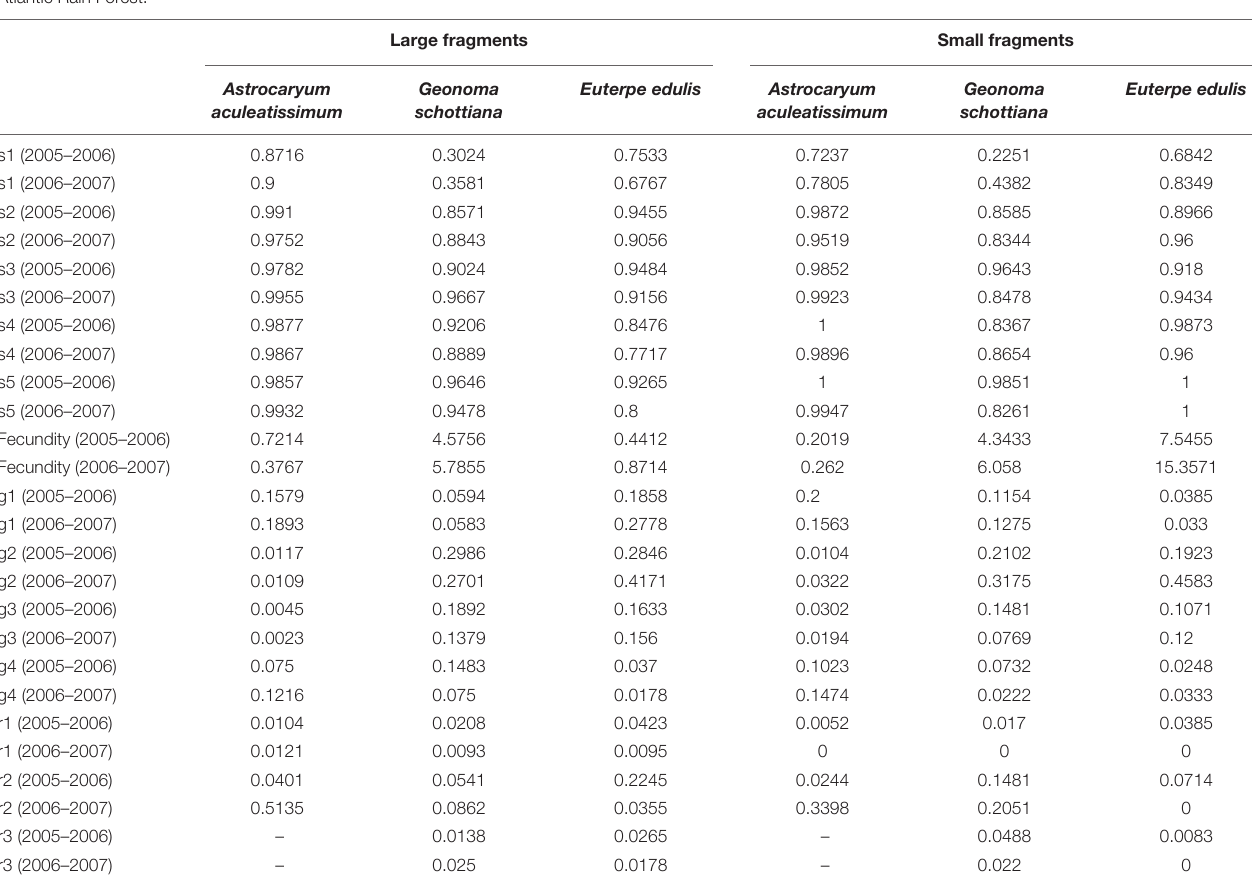
TABLE 3 | Lower-level vital rates for Astrocaryum aculeatissimum , Euterpe edulis , and Geonoma schottiana in three small and two large forest fragments in the Atlantic Rain